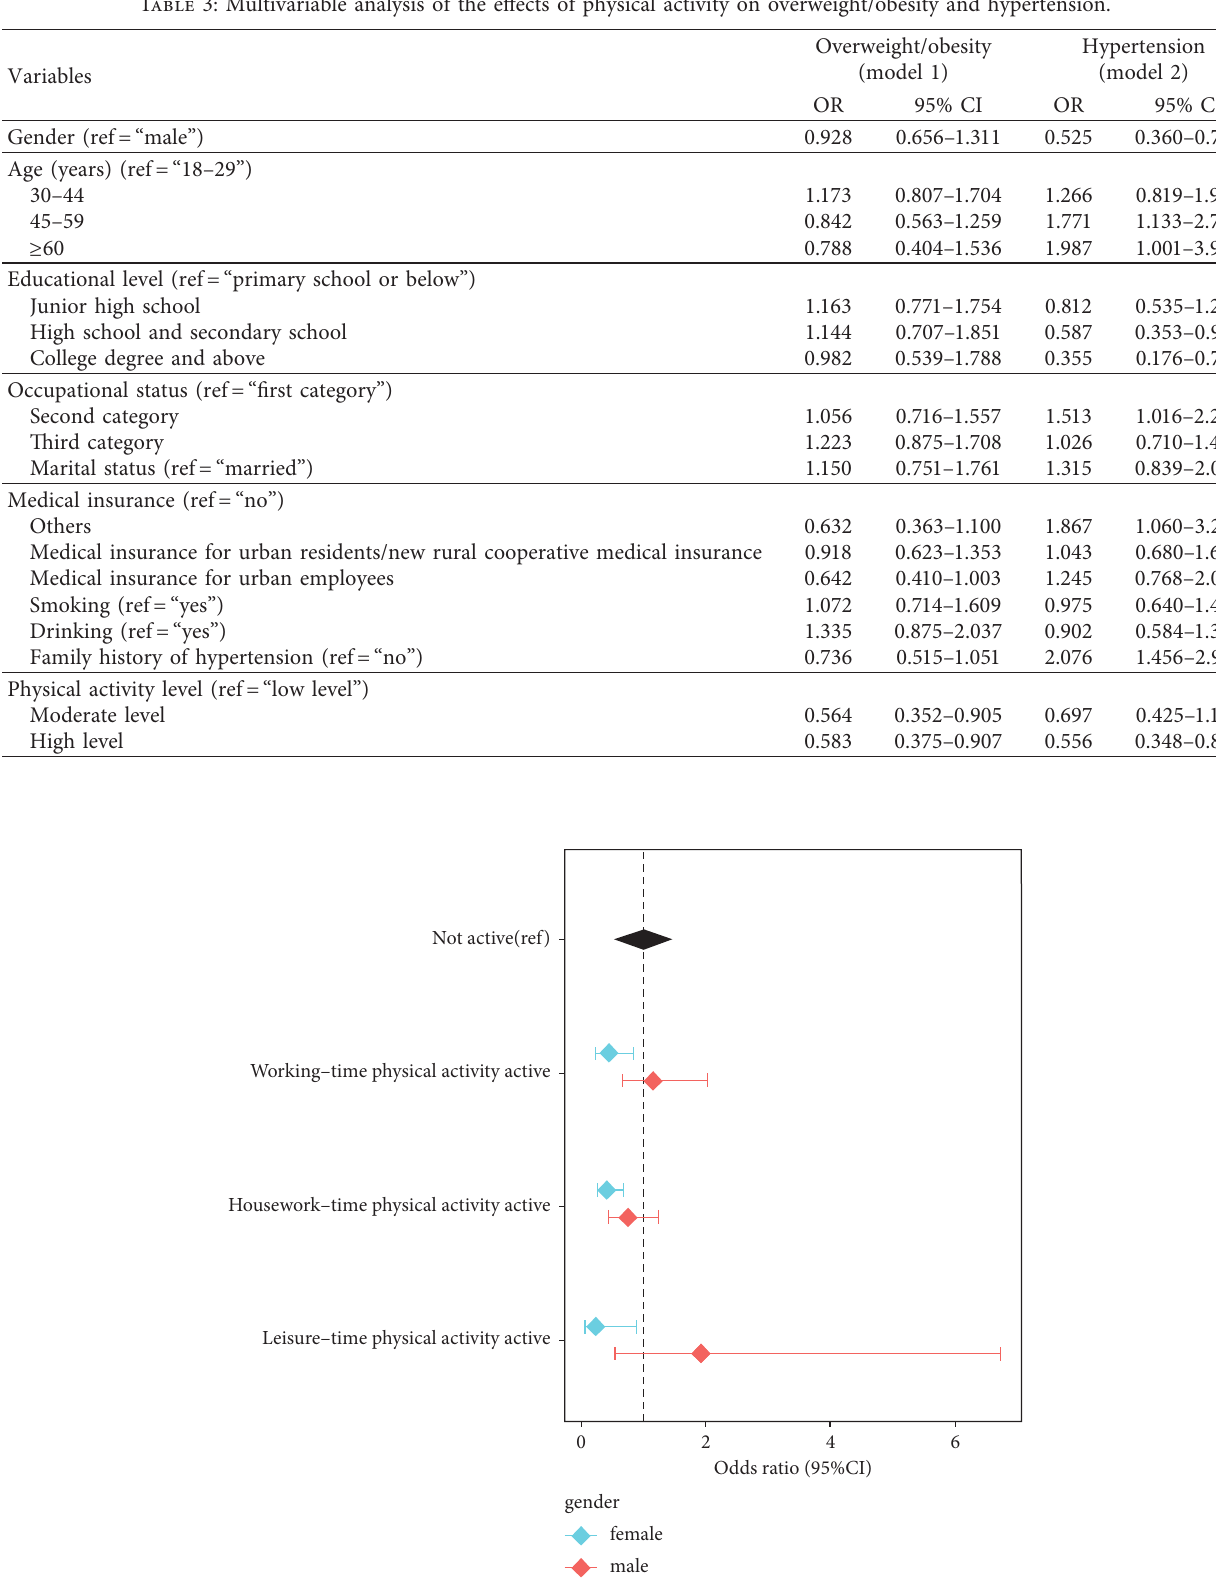
Figure 1: The impact of different types of physical activity on hypertension (adjusting for gender, age, occupational status, educational level, marital status, smoking, drinking, and family history of